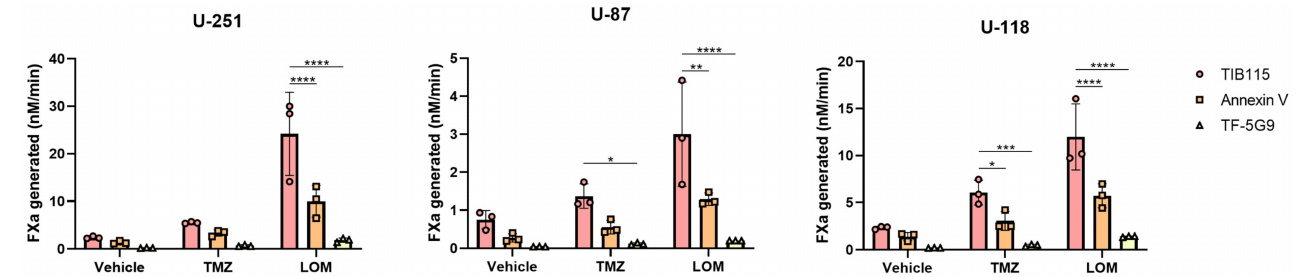
Figure 4. TMZ- and LOM-induced TF activity is fully prevented by TF-blocking antibody mAb 5G9 and reduced by PS-binding Annexin V. FXa generation assay in the presence of TIB115 (IgG1 control), PS-binding unlabeled Annexin V or coagulation blocking TF antibody 5G9. The amount of generated FXa was measured at 30 min after the start of the reaction in the presence of 1 nM FVIIa and 50 nM FX and corrected for the number of cells present per sample. Representative experiments are shown ( n = 3) from biological triplicates for each condition. Two-way ANOVA with Tukey’s multiple comparison test was used for statistical evaluation. * p < 0.05, ** p < 0.01, *** p < 0.001, **** p < 0.0001 vs vehicle